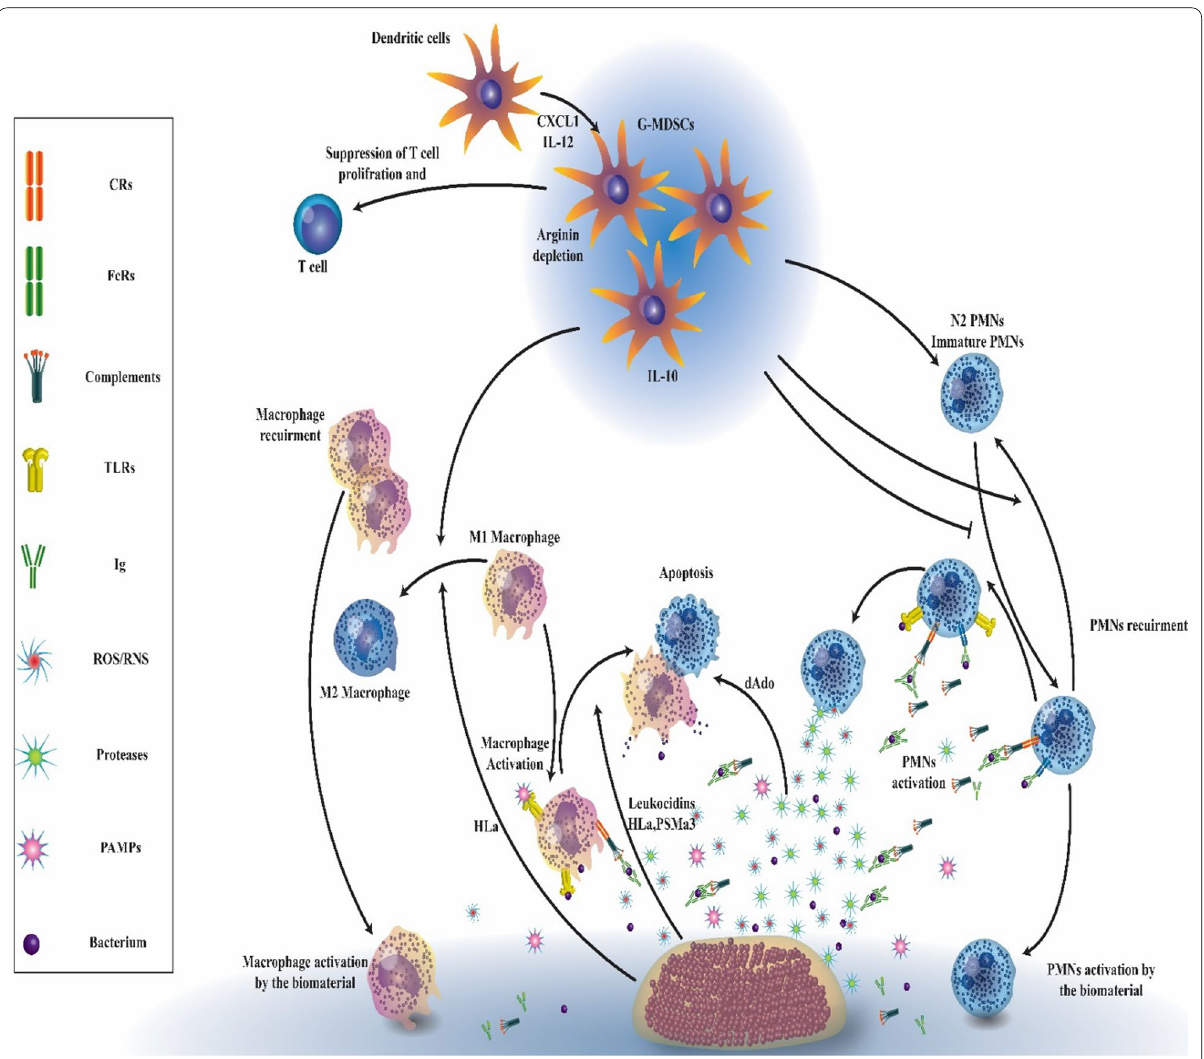
Fig. 3 The interactions between immune cells and biofilm infection. Biofilm-associated biomaterials and bacteria interact with humoral and cellular components of the immune system. Leukocyte chemokinesis and activation are triggered by the release of pathogen-associated molecular patterns (PAMPs), opsonization of bacteria, and complement activation through the interaction with toll-like receptors (TLRs), immunoglobulin Fc receptors (FcRs), and complement receptors (CRs). Bacteria, in turn, induce the release of factors such as CXCL1, IL-12, IL-10, deoxyadenosine